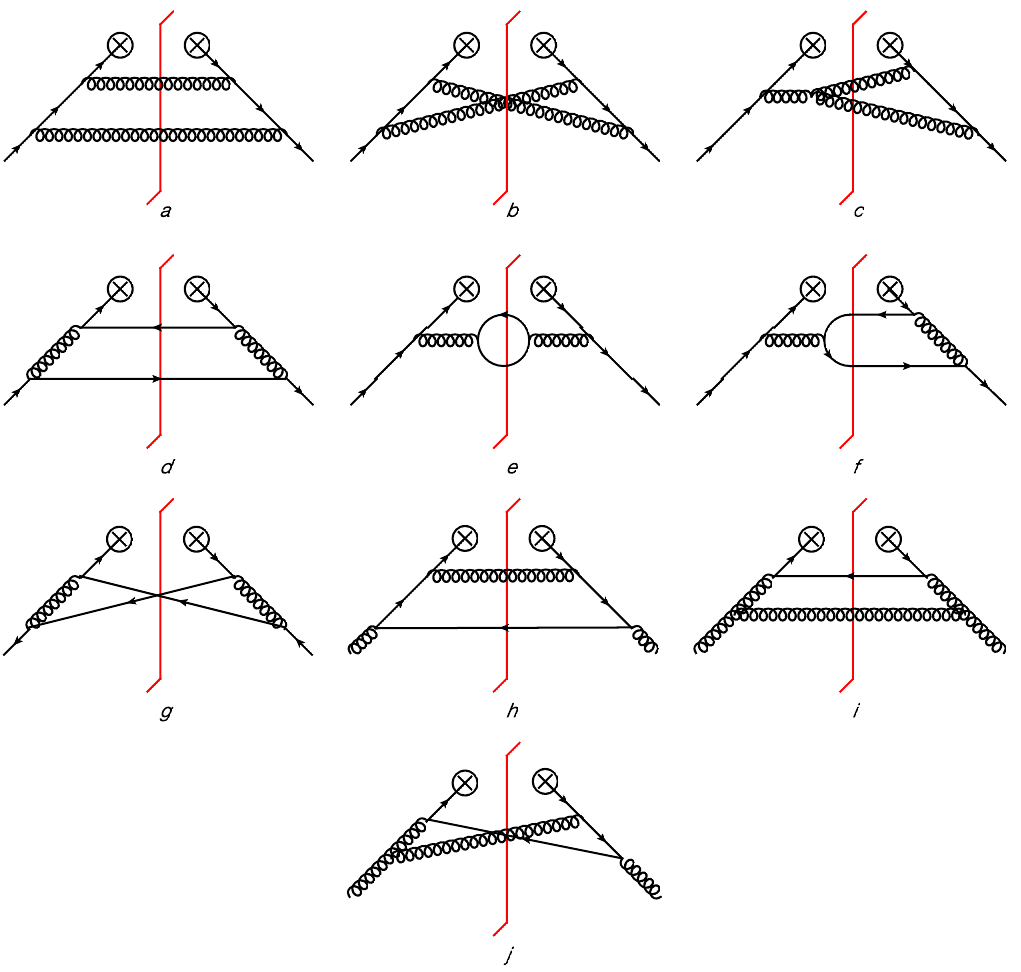
Figure 5 . Cut diagrams for the double-real